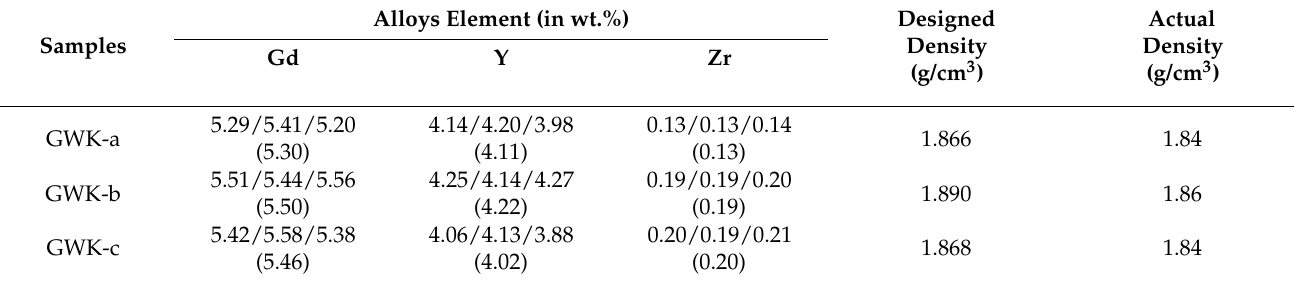
Table 1. Actual composition and density of as-cast GWK alloys.